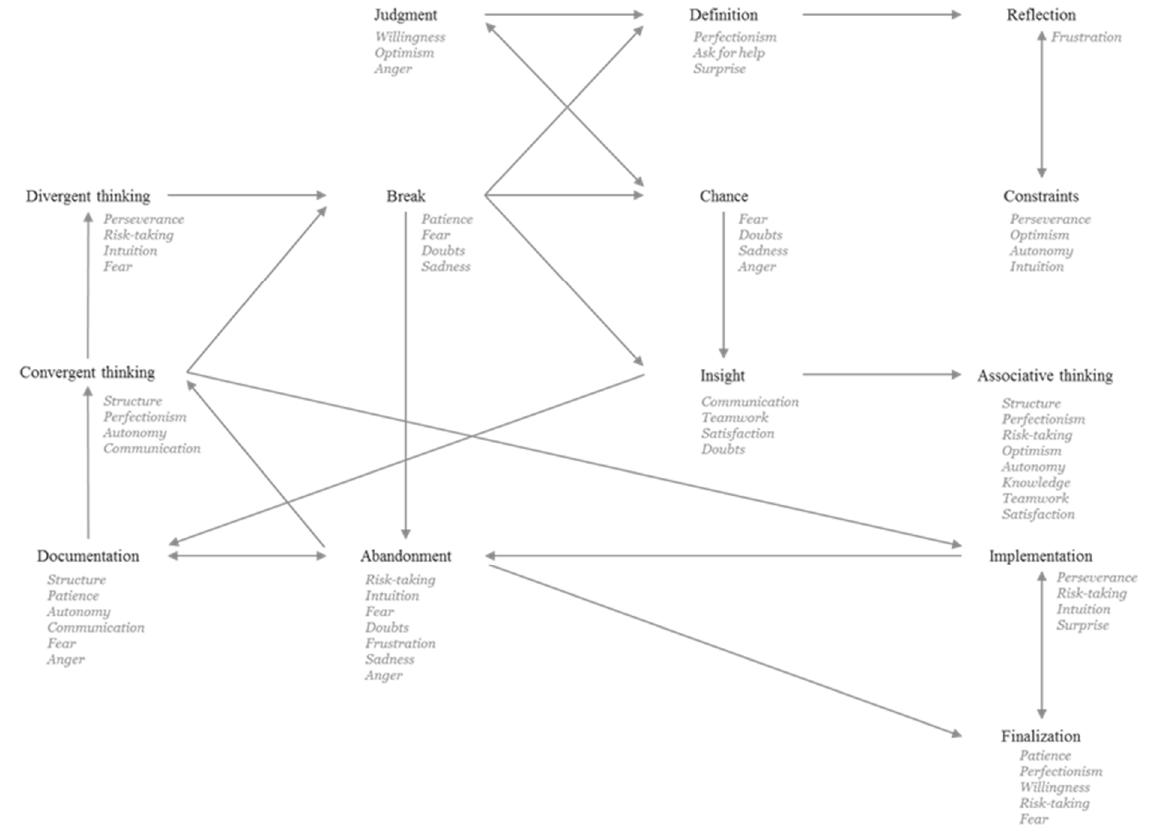
Figure 5. Graphical representation of the transitions between the stages of the creative process and the multivariate factors associated with each stage.